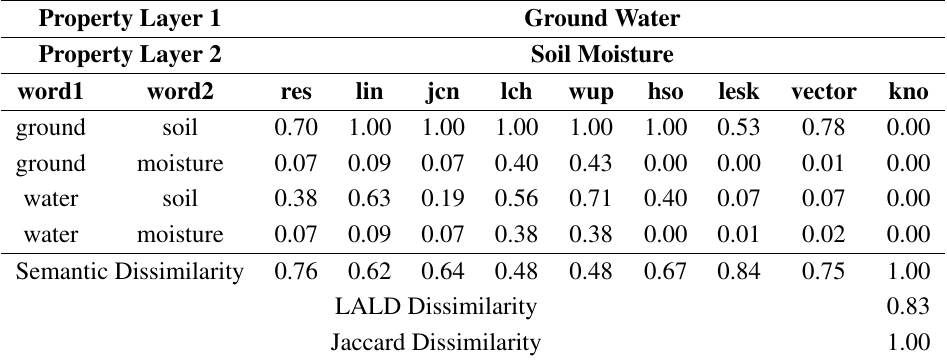
Table 7. Word pair similarity scores and dissimilarity values between ground water and soil moisture